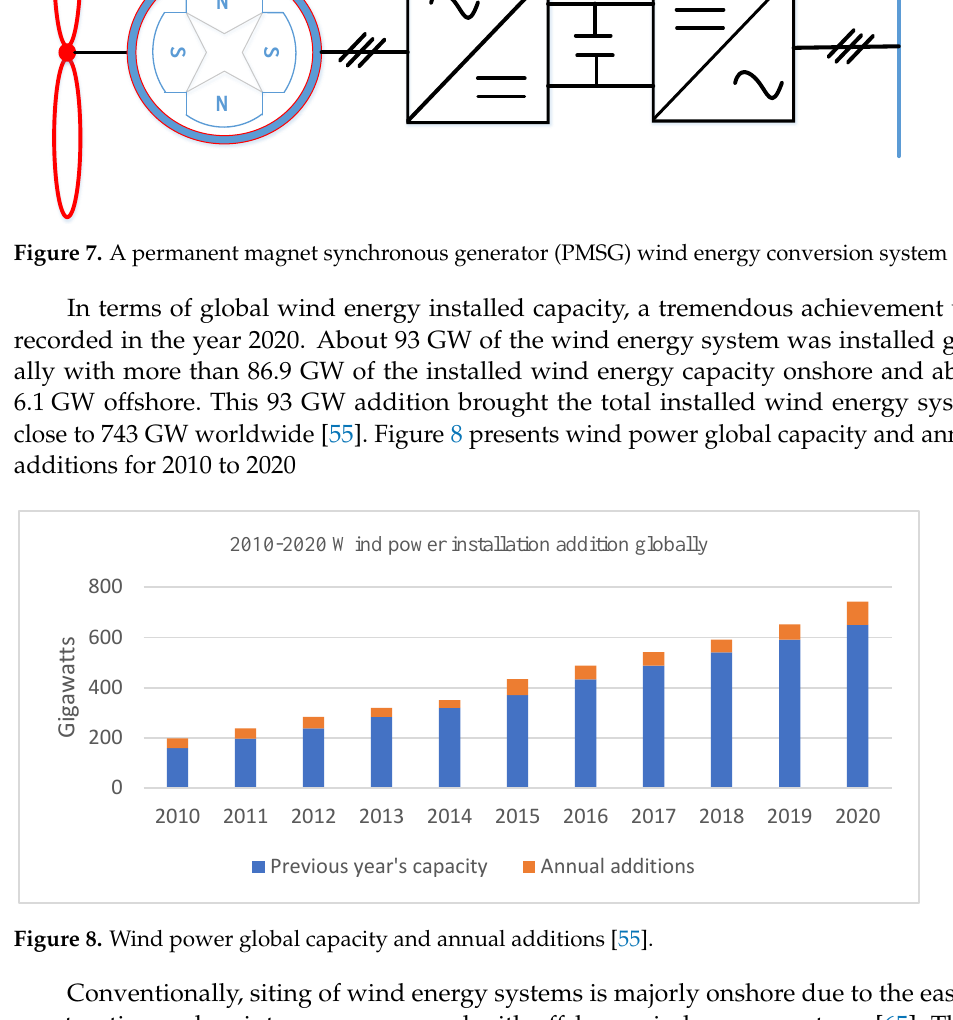
Figure 7. A permanent magnet synchronous generator (PMSG) wind energy conversion system [63].